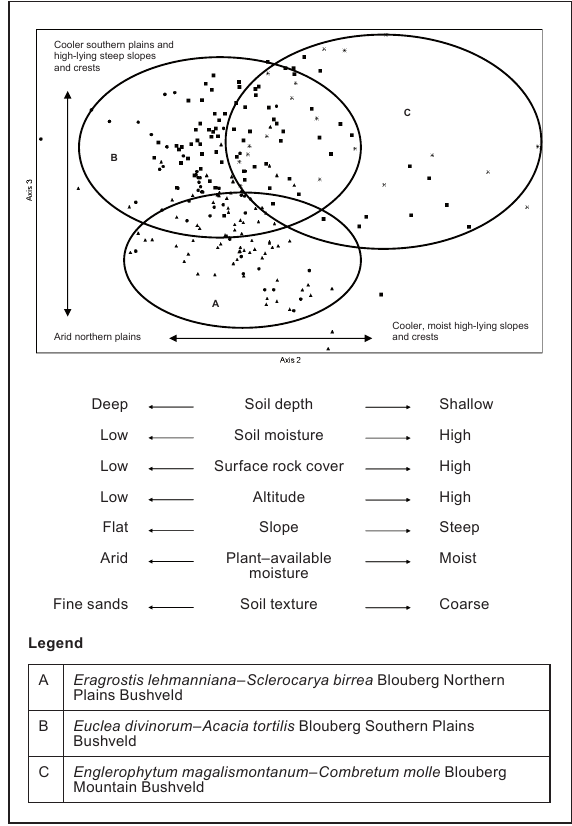
Figure 4 Relative positions of relevés along the second and third axes of the DECORANA ordination (Hill 1979b) of the vegetation data from the Blouberg Nature Reserve.